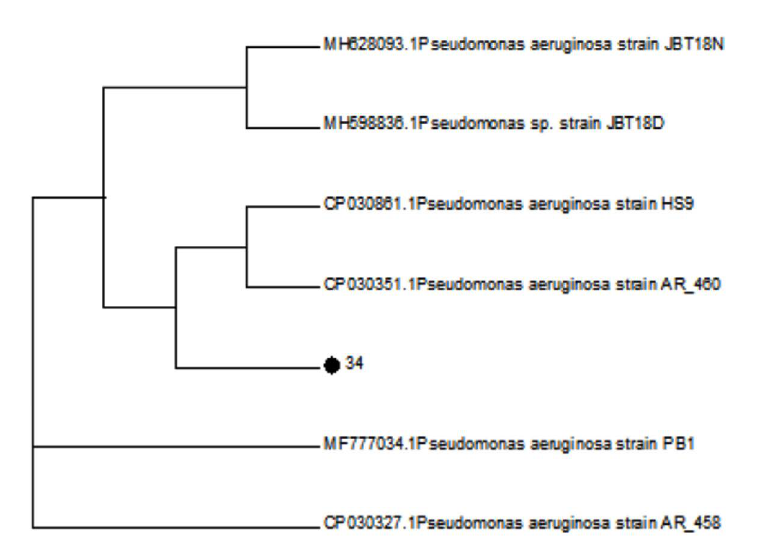
Fig. 9. Phylogram of Pseudomonas aeruginosa LC425424